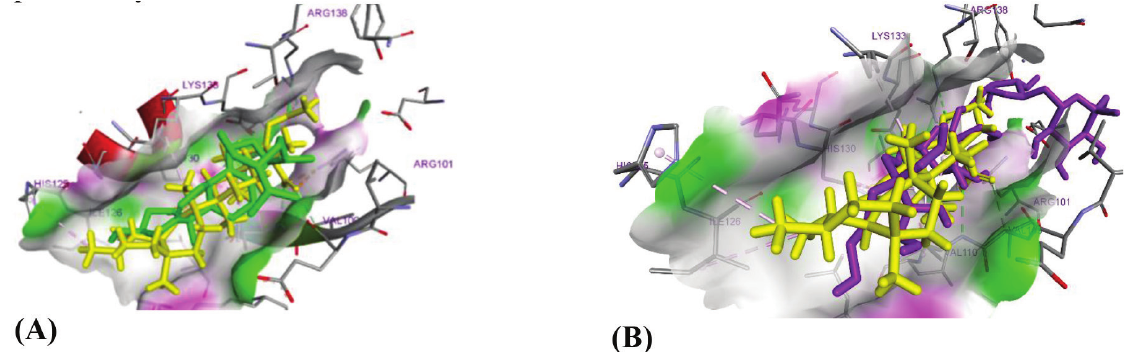
Figure 6. (A) 3D visualization of the native AKBA ligand compatible conformation (yellow molecule) with sitosterine (green mol- ecule); (B) AKBA ligand compatible conformation (yellow molecule) with inuline (purple molecule).